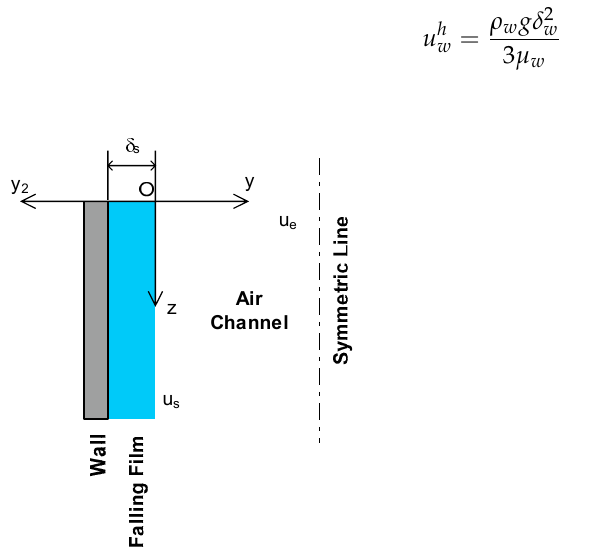
Figure 3. Schematic diagram of control volume analysis of the humidification section. Eams [74] predicted the water evaporation rate as shown in Equation (20).